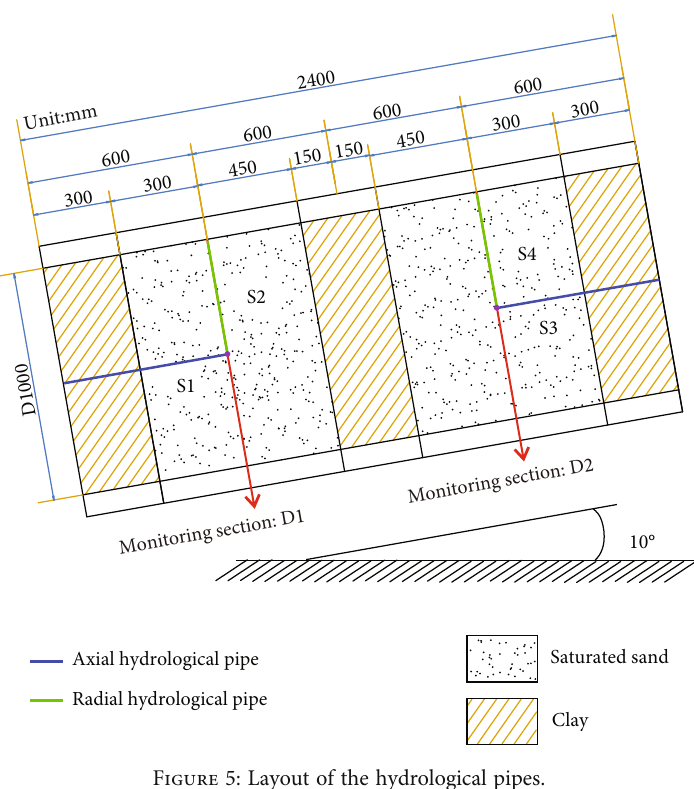
Figure 5: Layout of the hydrological